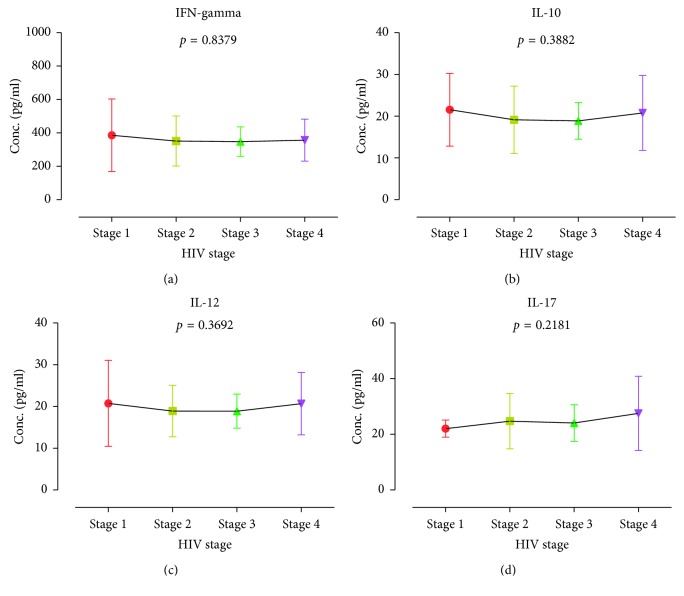
Cytokine distribution of the study participants according to the stage of HIV: (a) IFN-gamma, (b) IL-10, (c) IL-12, and (d) IL-17.